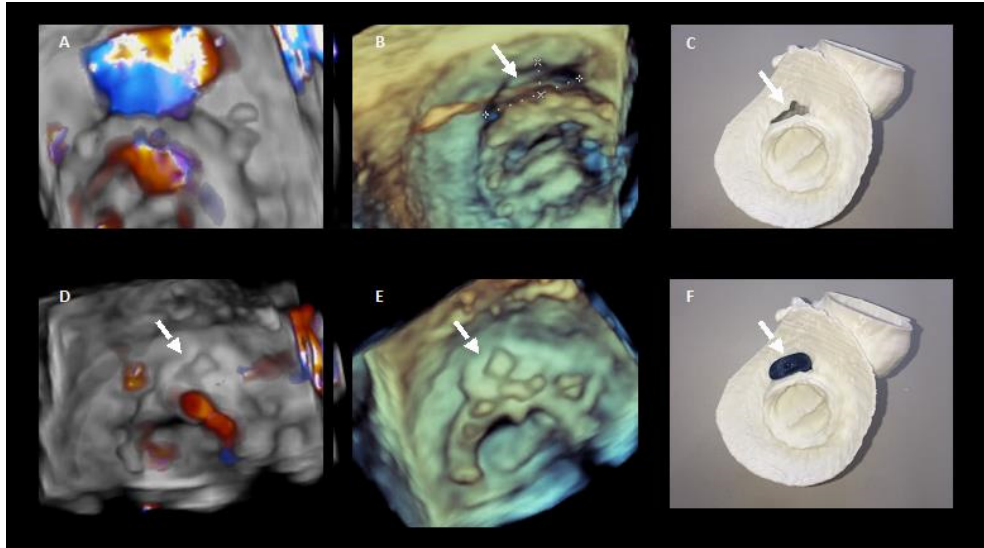
Figure 6. 3D printing in preprocedural planning of paravalvular leak closure. ( A , B ). 3D echocardiography images of the PVL. ( D , E ) 3D echocardiography images showing the result after percutaneous closure. ( C , F ) show the 3D model of the PVL and how it colud be closed with the device.